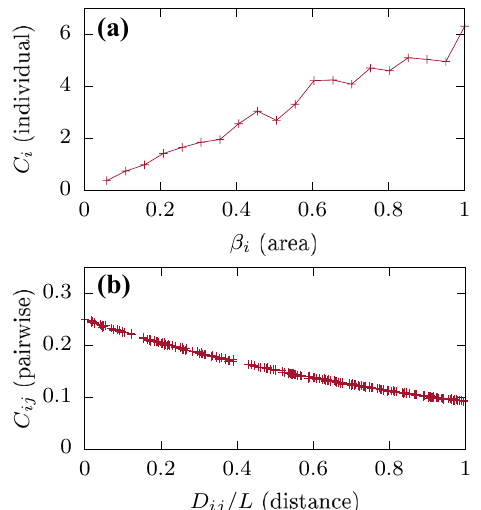
20 . ( a ) individual patch connectivity versus normalized = D ij i j . = L ∀